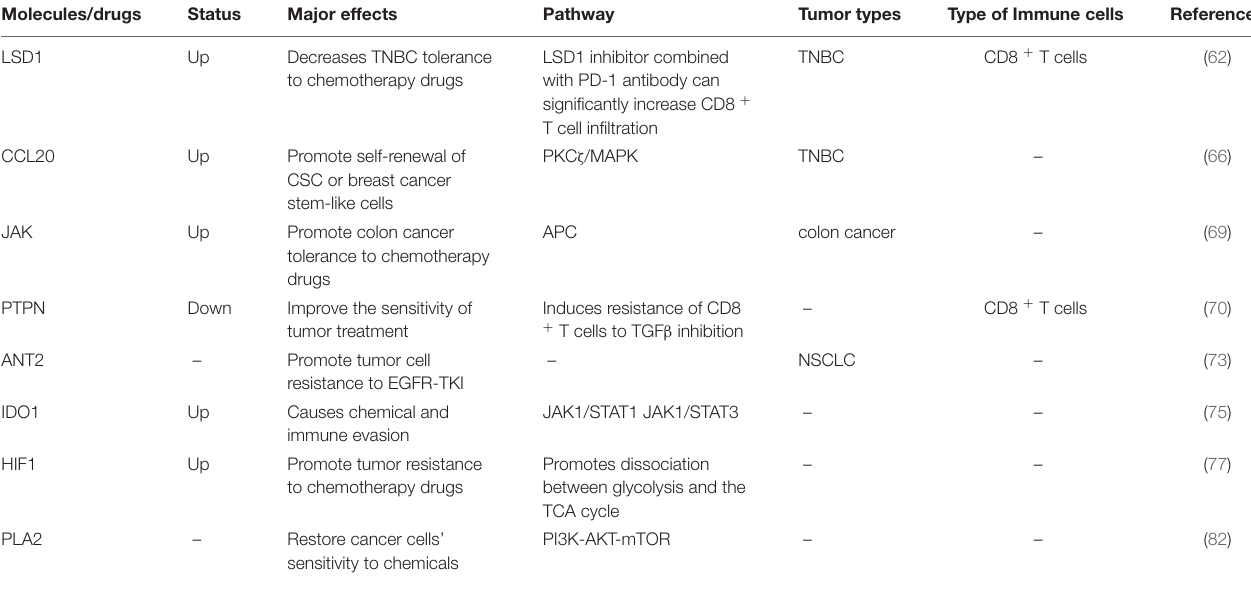
TABLE 4 | Drug resistance and